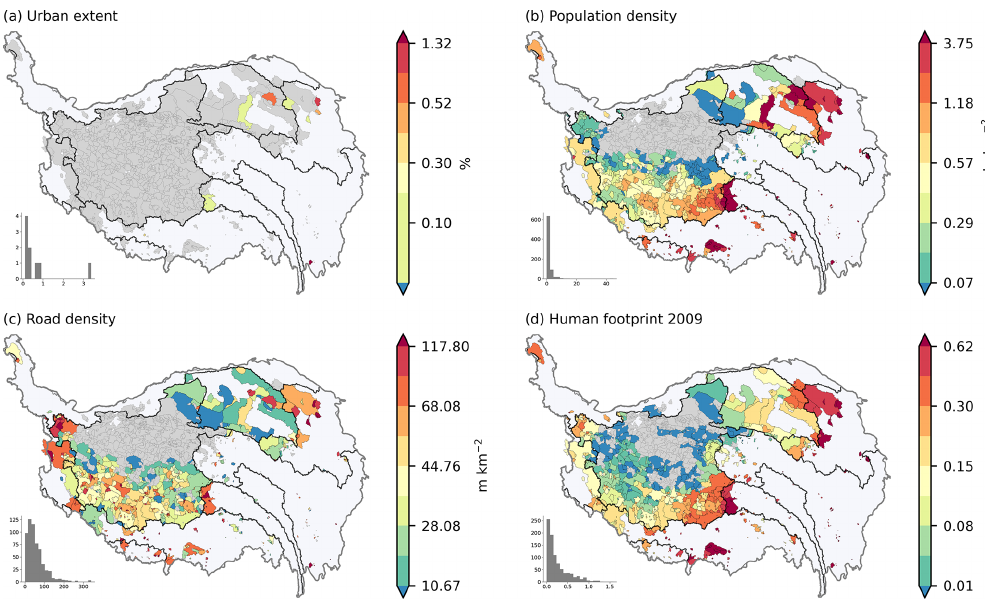
Figure 11. Spatial distribution of anthropogenic activity characteristics for inter-lake catchments on the